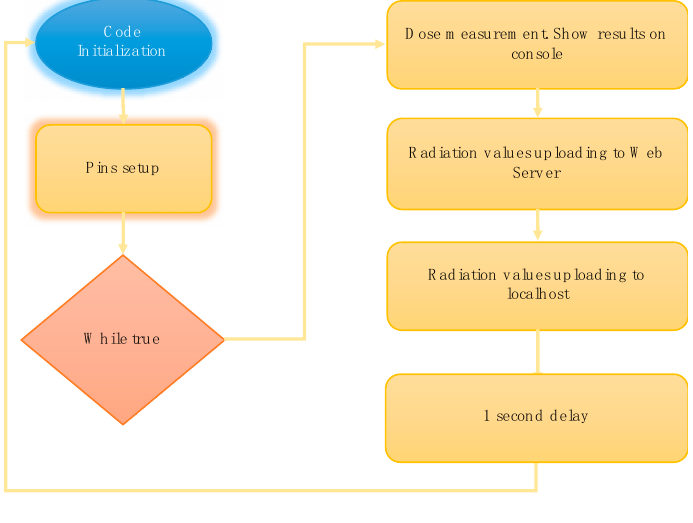
Figure 7. System general diagram.